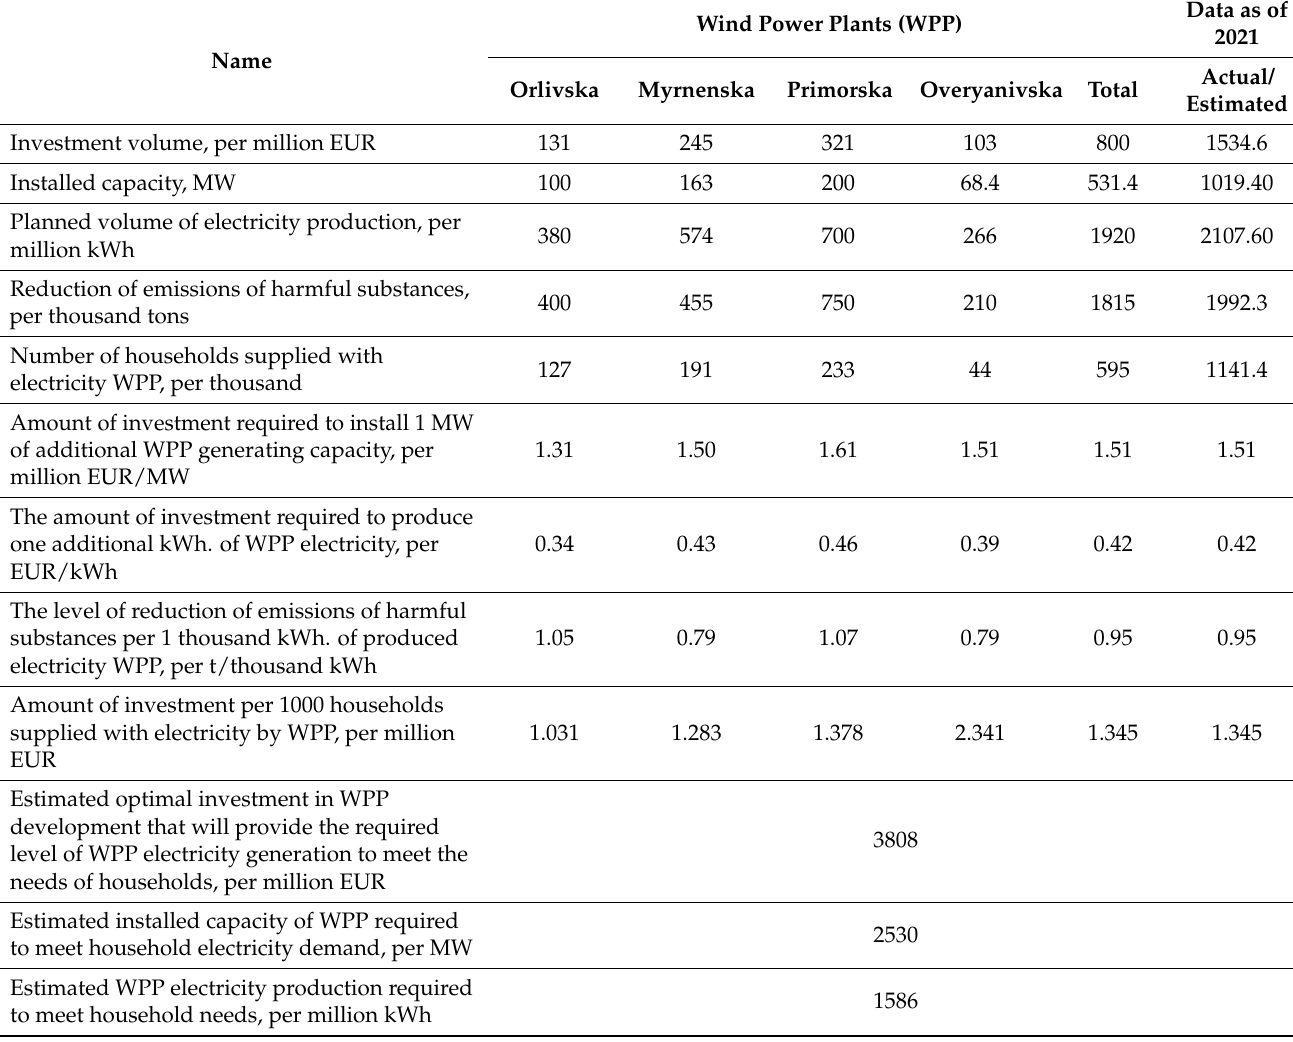
Table 3. Actual, estimated, and forecast technical and economic indicators of attracting investment in the development of the wind power sector within the south-eastern